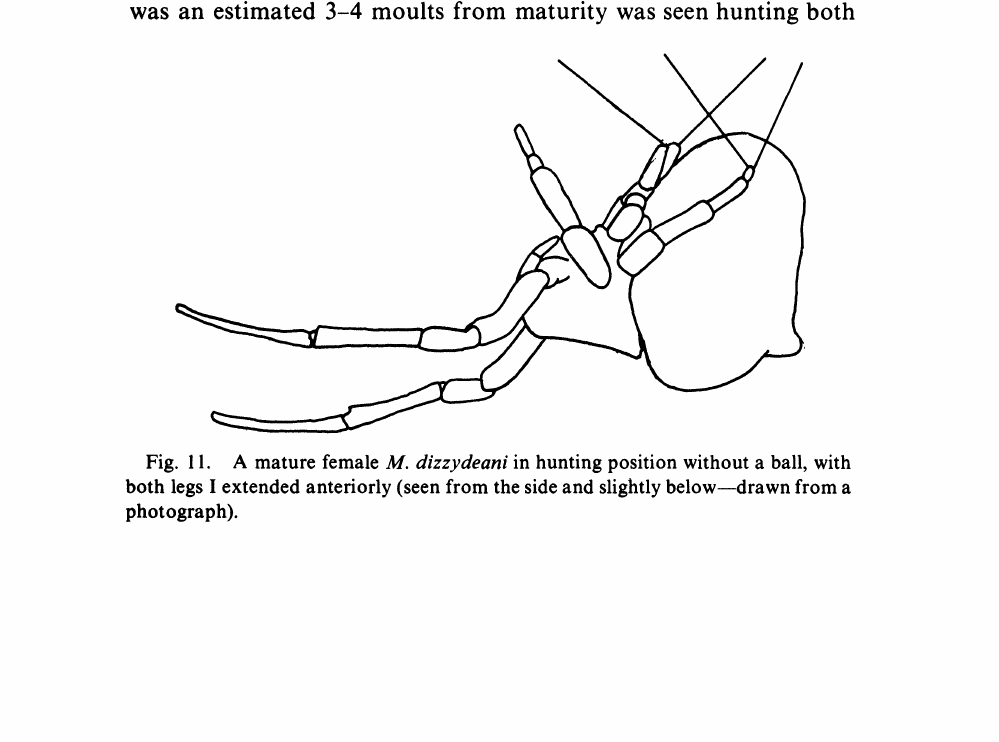
Fig. 11. A mature female M. dizzydeani in hunting position without a ball, with both legs extended anteriorly (seen from the side and slightly below--drawn from a